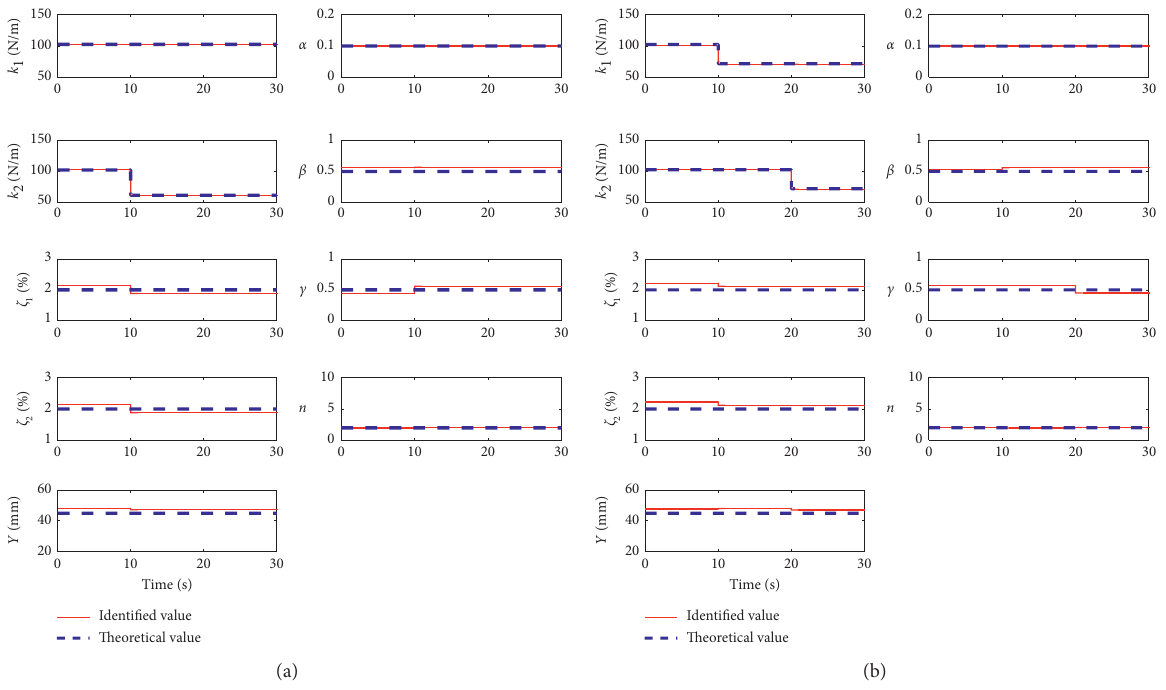
Figure 18: Identification results under Kobe earthquake wave. (a) Case 1. (b) Case 2. Table 10: Relative errors between identification results and theoretical values under El-Centro earthquake